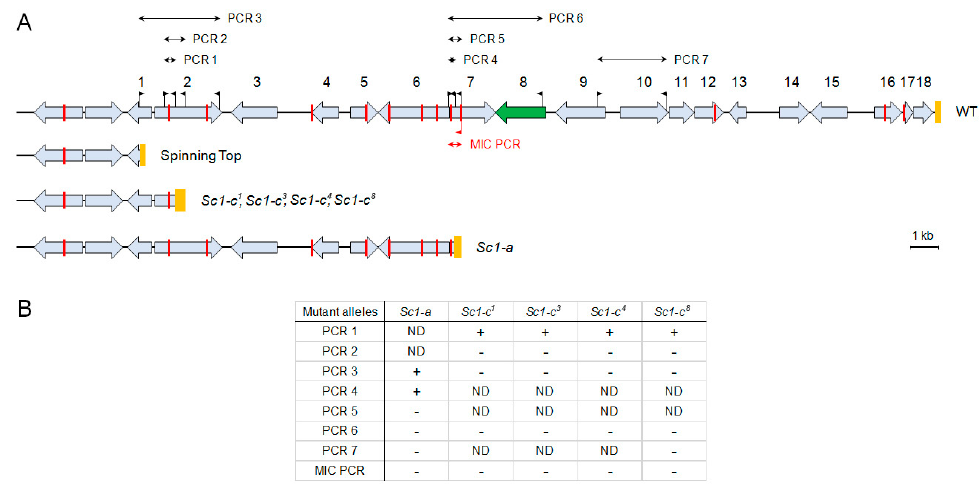
Figure 2. ( A ) Genomic map of P. tetraurelia strain 51 MAC sca ff old 77 right end (WT), and localization of three inferred deletions in the studied screwy mutants. The genes are shown as grey boxes with arrows; deleted in Spinning Top segment encompasses those with numbers. The Spade gene box is colored with green. Orange boxes indicate the telomere addition regions for the WT and Spinning Top; for other mutants they represent the regions in which the deletion breakpoints were mapped. The flags correspond to the primers used in chromosome walking PCRs and for MIC-specific PCR. Red bars indicate the positions of IES excision junctions in the MAC sequence. The red flag below the line is a MIC-specific primer within an IES. ( B ) Summarized results of all PCR tests in all mutants ( + stands for PCR product present, - stands for PCR product absent, ND – not done). For the list of the PCRs and the primers used see Table S1).